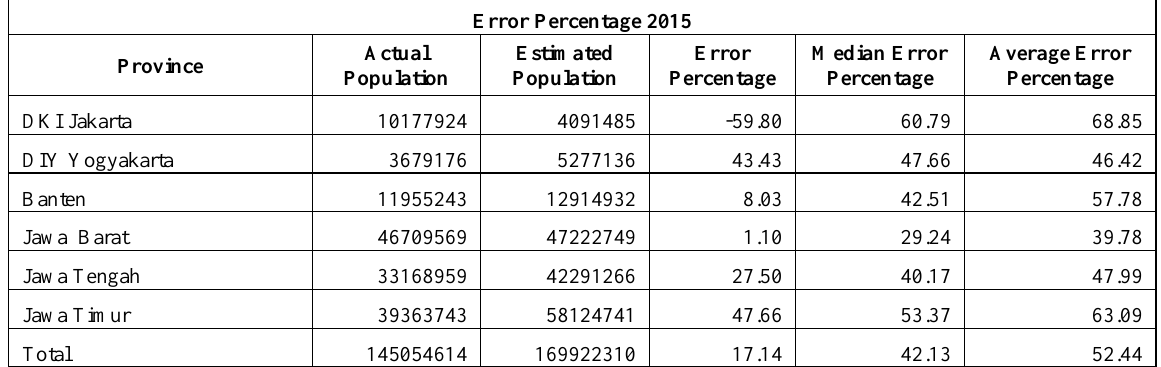
Table 3. Percent errors of the 2015 population estimates per province.